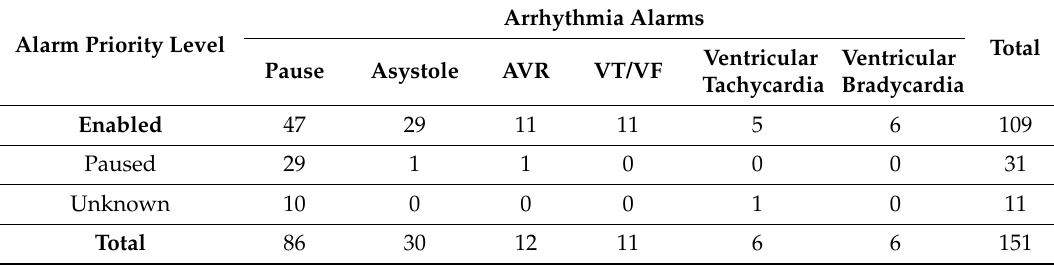
Table 1. Arrhythmia Alarms Audio Level (n = 151 alarms).